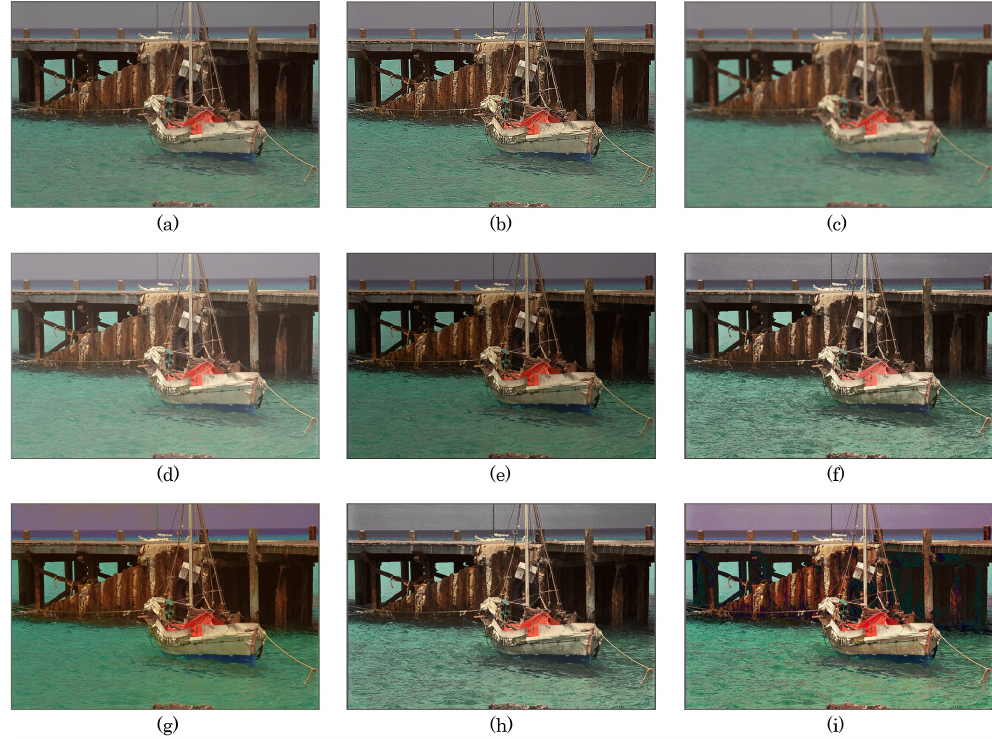
Figure 5. Raw image and output images from proposed and previous methods [1,12] (kodim11). ( a ) Raw image. ( b ) Sharpening ( I VSH = 2). ( c ) Smoothing ( I VSM = 2). ( d ) Brightness increase ( I VI = 30). ( e ) Brightness decrease ( I VD = 30). ( f ) CE ( I VC = 30). ( g ) Saturation improvement ( I S = 20). ( h ) CE under previous method [12] ( I VC = 30). ( i ) CE under previous method [1] ( I VC =